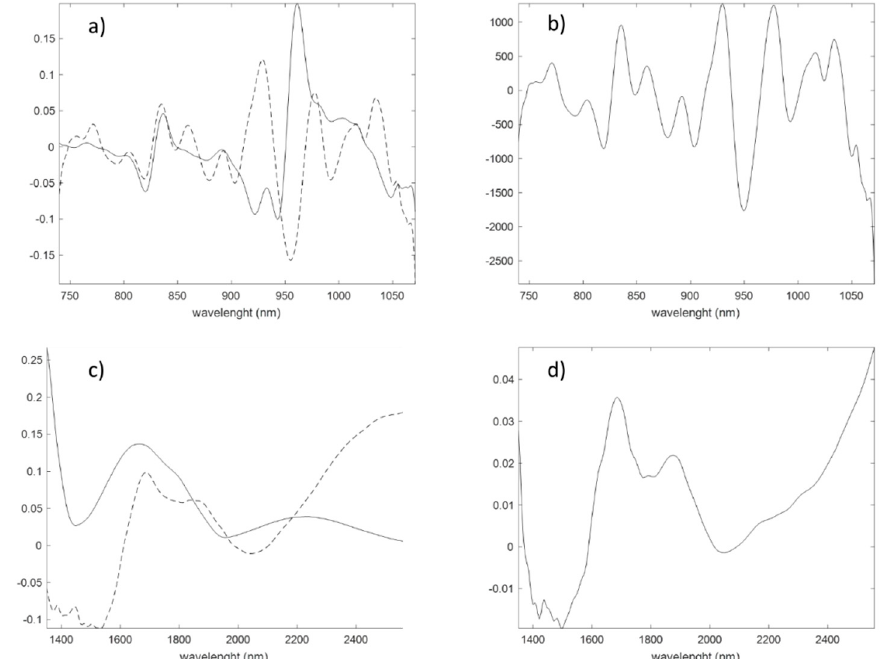
Figure 5. Loadings and regression coe ffi cients of the PLS models. SCiO: ( a ) first (solid line) and second (dashed line) loadings; ( b ) regression coe ffi cients. NeoSpectra: ( c ) first (solid line) and second (dashed line) loadings; and ( d ) regression coe ffi cients.